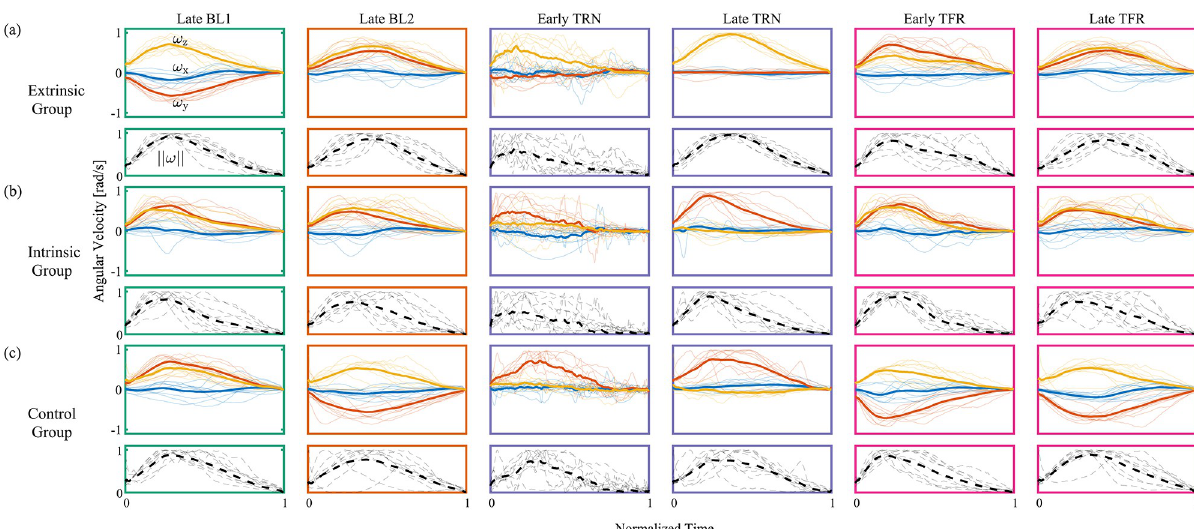
Fig 10. Comparison of angular velocity profiles at key stages. The solid shaded curves depict the three-trials averaged, time and amplitude normalized, angular velocity profile of each participant in key stages in intrinsic coordinates (x—blue, y—orange, and z—yellow). The solid bold curves depict the time and amplitude normalized angular velocity profiles averaged across participants. The dashed gray and black curves depict the individual and average angular speed, respectively. (a) Extrinsic group, (b) Intrinsic group, and (c) Control group. In each group, the upper panel depicts the velocity and the lower panel depicts the scalar speed. The velocity analysis complements the spherical axis analysis, as the ratio between the coordinates of the velocity profiles (i.e., the normalized vector) is the aiming axis.